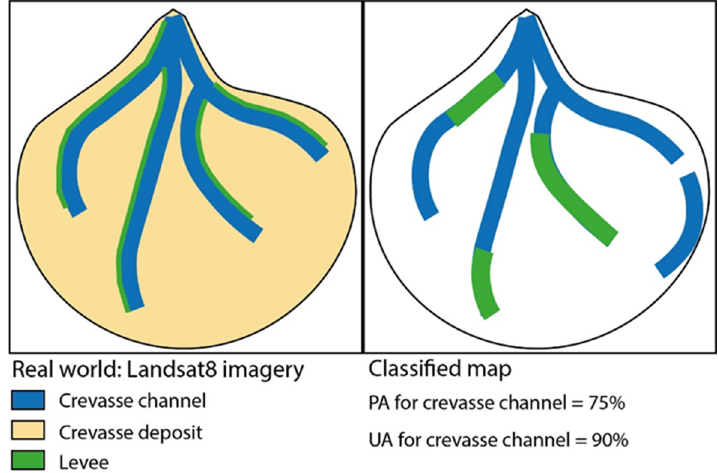
Table 1. The most accurate thresholds for each classification method.